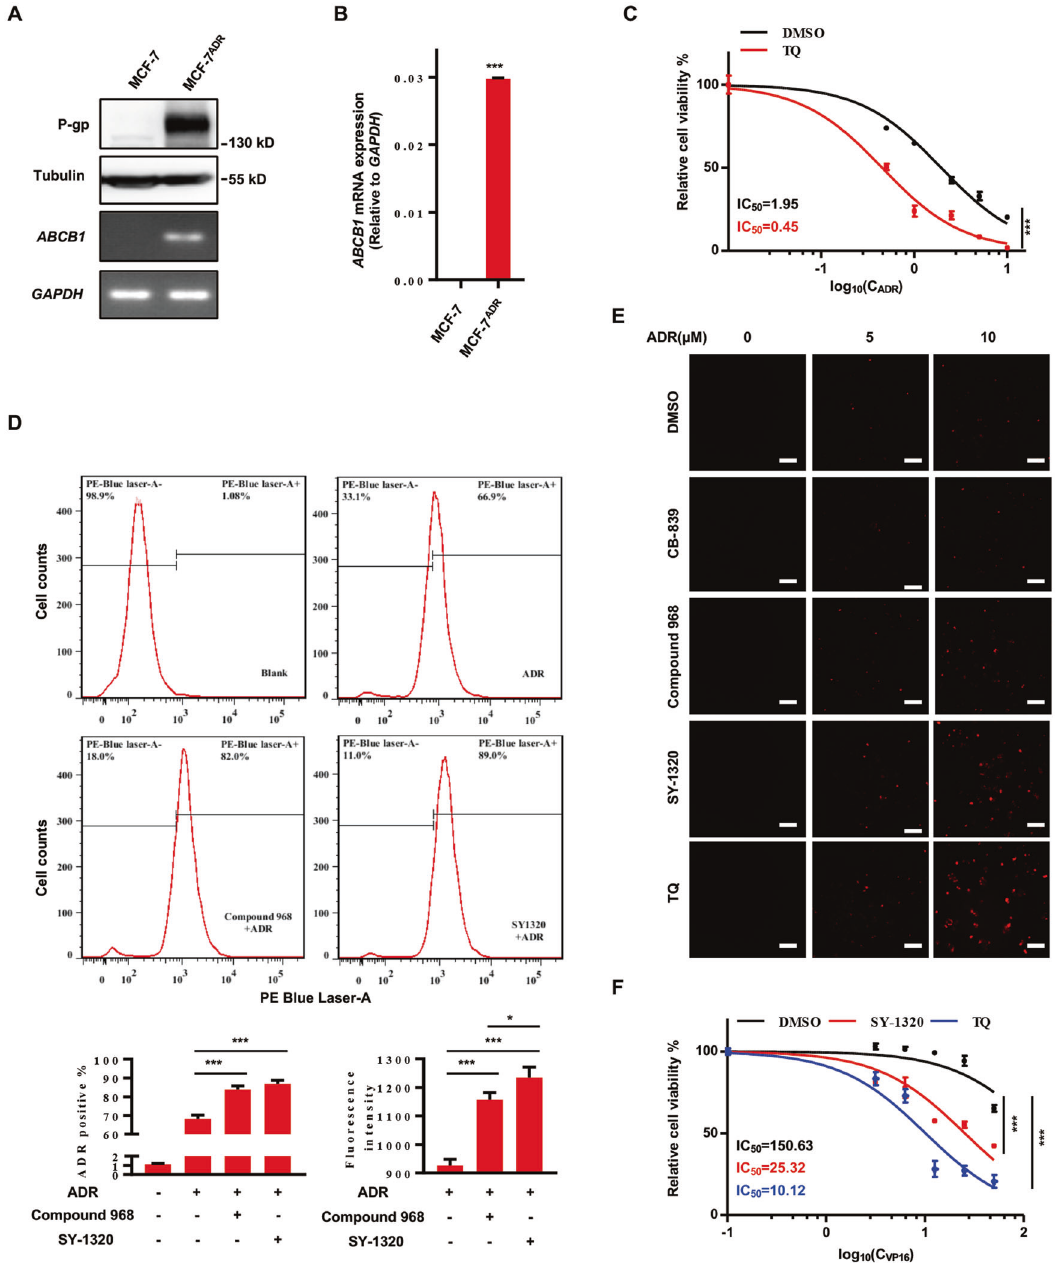
Fig. 6 SY-1320 promotes ADR accumulation in MCF-7 ADR cells by targeting P-gp. A , B Levels of P-gp protein and mRNA in MCF-7 or MCF-7 ADR cells were detected by western blot and RT-qPCR, respectively. C MCF-7 ADR cells were treated with ADR (2 μ M) alone or together with TQ (0.5 μ M) for 48 h. Cell viability was detected using the CCK8 assays. D , E Intracellular ADR accumulation was detected by fl ow cytometry ( D ) and fl uorescence ( E ). Scale bars, 50 µm. F Both SY-1320 and TQ increased the sensitivity of MCF-7 ADR cells to etoposide (VP16). Data are presented as mean ± SD of three independent experiments. * P < 0.05, *** P < 0.001, two-tailed Student ’ s t test.